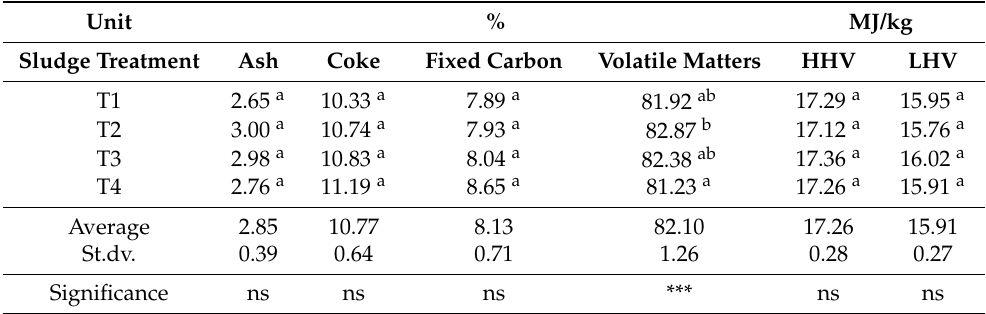
Table 5. Proximate analysis of Virginia mallow biomass after application of different amounts of sewage sludge. Unit % MJ/kg Sludge